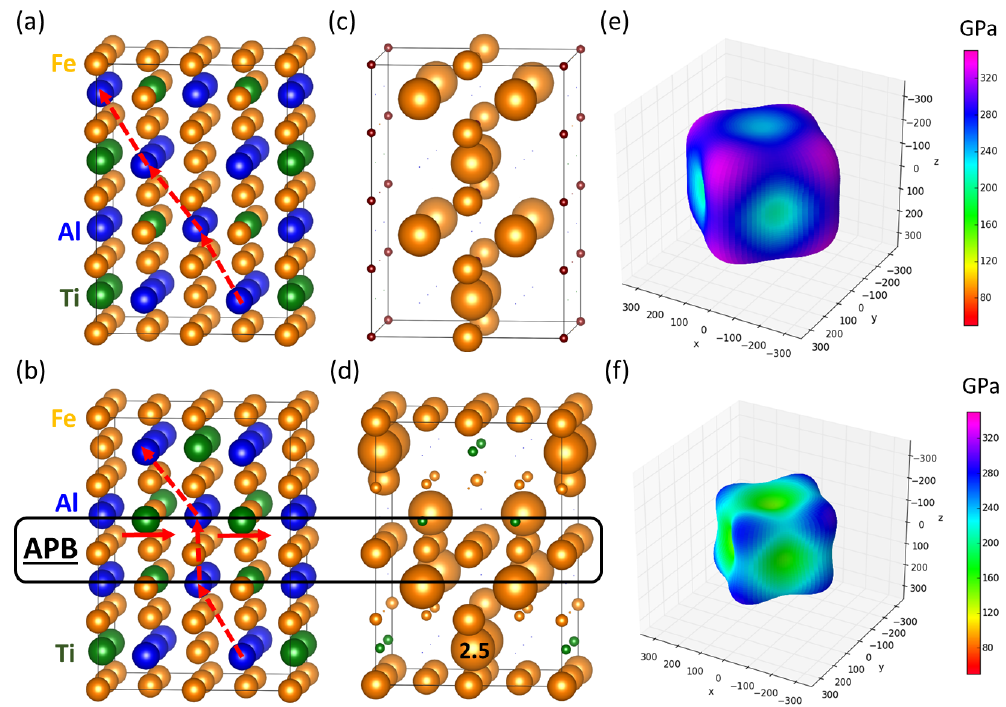
Figure 7. Schematic visualization of the Fe-Al-Ti phase of cuboids modeled by a double 64-atom supercell without any anti-phase boundaries ( a ) and with an anti-phase boundary (APB) ( b ) together with the corresponding ab initio calculated local magnetic moments ( c , d ) and elastic properties ( e , f ) visualized in the form of a directional dependence of the Young’s modulus for both the APB-free and the APB-containing case, respectively. The magnitude of the local magnetic moments is visualized by the diameter of spheres representing the atoms (the scaling can be deduced from an example of one of the Fe atoms for which its local atomic magnetic moment of 2.5 µ B is listed). The change of the overall magnetic moment is very significant: the APB-containing state (see part ( b )) has the total magnetic moment higher by 140% than the APB-free one (see a similar effect in, e.g., Ref. [69]). Red dashed arrows in ( a , b ) indicate layering of Al atoms, which is altered due to the APB shift (full red